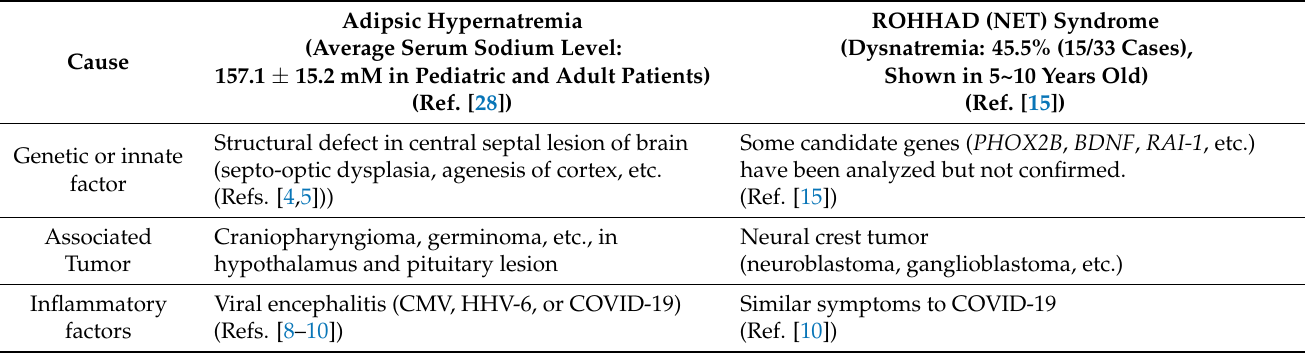
Table 1. Etiology in adipsic hypernatremia and ROHHAD (NET)